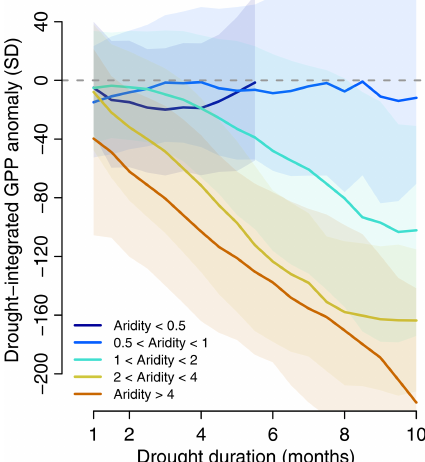
Figure 3. Drought duration controls integrated biospheric drought response across global aridity regions. Lines obtained through averaging within a 1-month moving window, i.e. GPP anomaly at 4 months of drought duration is inferred with data between 3.5 and 4.5 months of drought duration. GPP anomalies are expressed as accumulated z scores. Lines are computed if more than 50 val- ues are available within the moving window. Shadows denote the interquartile range determined within moving